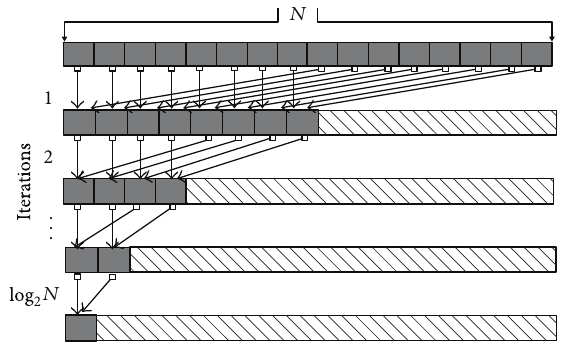
Figure4:Coalescedaccesspatternfortheelementwiseoperationon a vector and the subsequent parallel reduction operation per thread group in shared